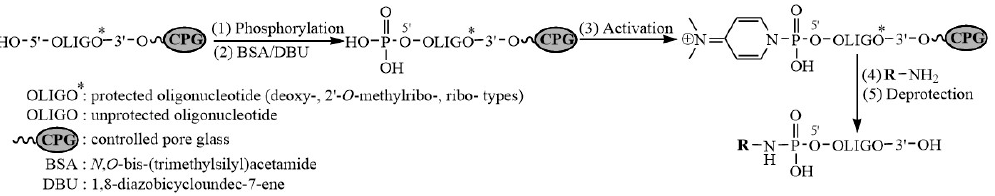
Figure 1. The common scheme for oligonucleotide solid-phase 5 ′ -functionalization. R–NH 2 struc- tures: see Supplementary Table S1 .